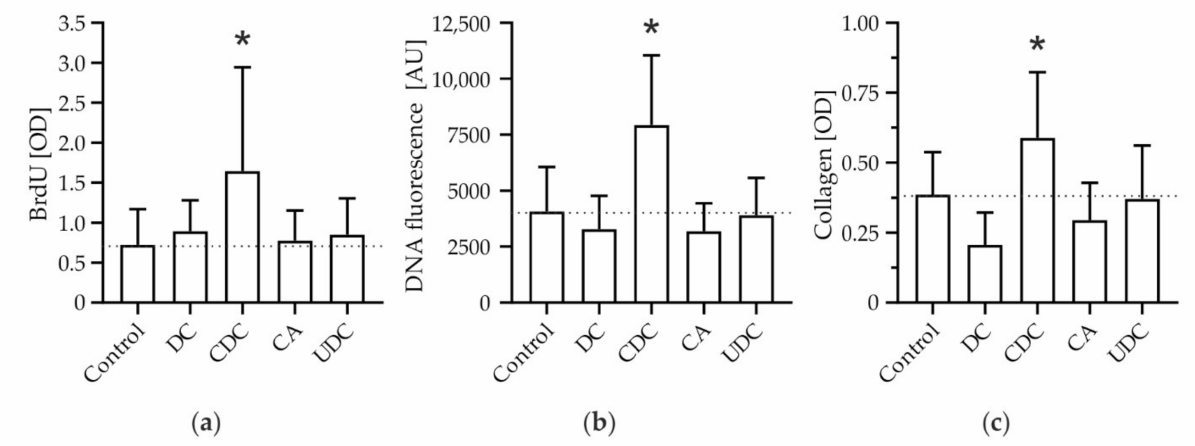
Figure 1. Chenodeoxycholate (CDC), but no other bile salt, specifically promotes hepatic stellate cell (HSC) expansion and extracellular matrix deposition. Primary murine HSCs were stimulated with deoxycholate (DC), CDC, cholate (CA), and ursodeoxycholate (UDC), respectively (100 µ M, each). Controls were treated with diluent (0.01% dimethyl sulfoxide). ( a ) Proliferation was determined after 7 days by BrdU assays ( n = 9). ( b ) The amount of DNA was used as a surrogate of cell number and quantified by PicoGreen TM dsDNA assays after 14 days ( n = 5). ( c ) Collagen deposition was determined by Sirius Red staining after 14 days ( n = 9). Results are shown as mean ± SD (* p < 0.05 vs. control, Fisher’s